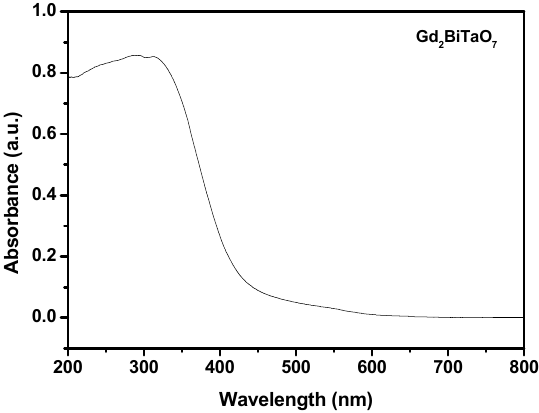
Figure 2. UV-Vis diffuse reflectance spectra of Gd 2 BiTaO 7.